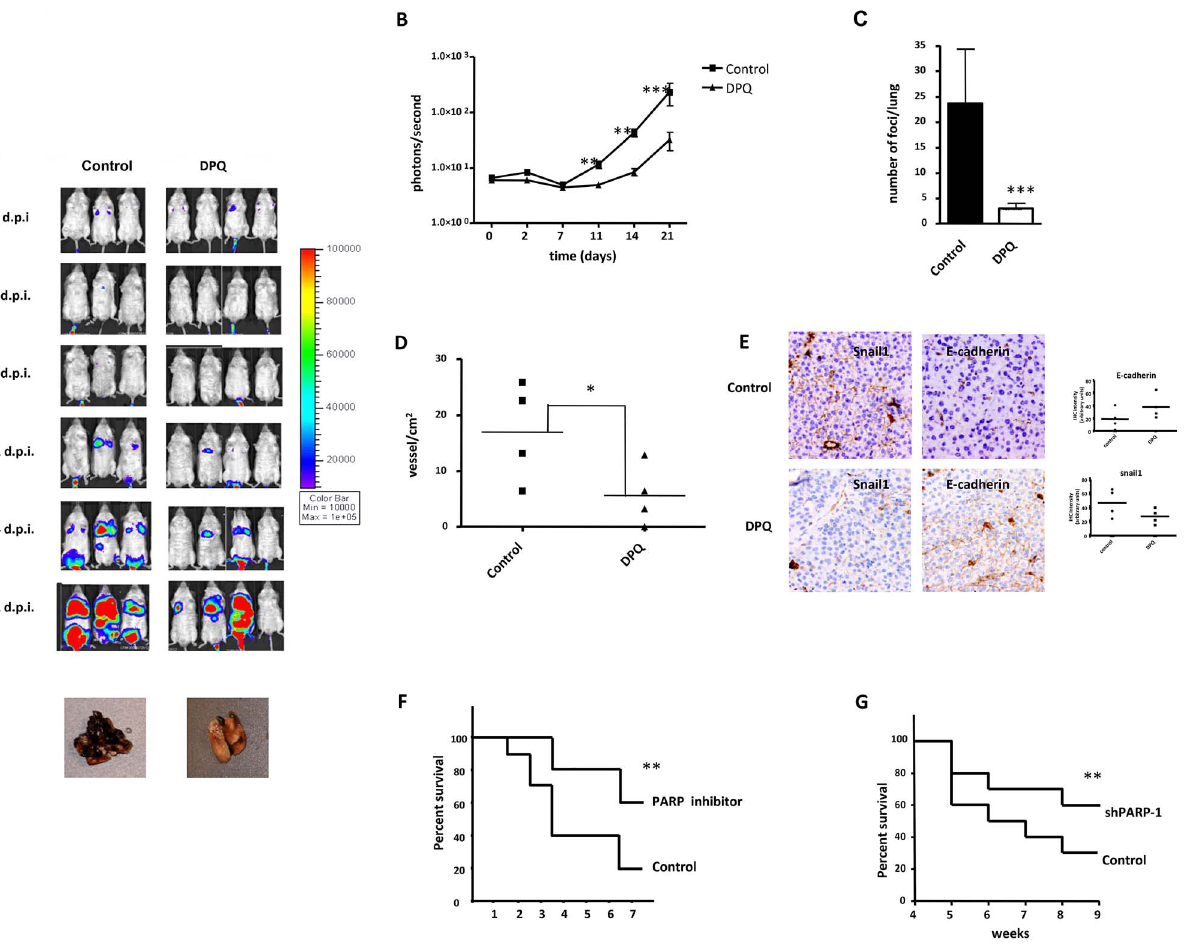
Figure 7. Decreased melanoma-induced lung metastasis following PARP inhibition. ( A ) Mice were inoculated with the murine melanoma cell line B16-F10-luc. Localization and the intensity of luciferase expression were monitored by in vivo bioluminescence imaging (dpi, days post cells injection). At the bottom of Figure A two lungs from vehicle (left) or DPQ (right) treated mice are shown. Lungs were extracted to analyze the number of melanoma foci. Quantification of luciferase activity over time shows the average light (photons) emission in photons/s ( B ) (**P , 0.01; ***P , 0.001 versus DPQ). ( C ) The number of metastatic foci/lung were counted macroscopically (*** P , 0.001). ( D ) Angiogenesis was measured using a specific endothelial cell marker (tomato lectin) and measured as blood vessels per mm 2 in tumor sections of lung metastasis (Columns, mean 6 SE. * P , 0.05, with respect to control and DPQ–treated mice. ( E ) Immunohistochemistry staining of Snail1 and E-Cadherin in lung metastasis and quantitation using ImageJ , colour deconvolution plugin ( F and G ) Kaplan-Meyer survival curve shows the survival advantage of DPQ-treated mice following intravenous tail injection of melanoma cells as previously described in mice treated with DPQ ( F ) or injected with B16F10 stably silenced for PARP-1 ( G ) (** P , 0.